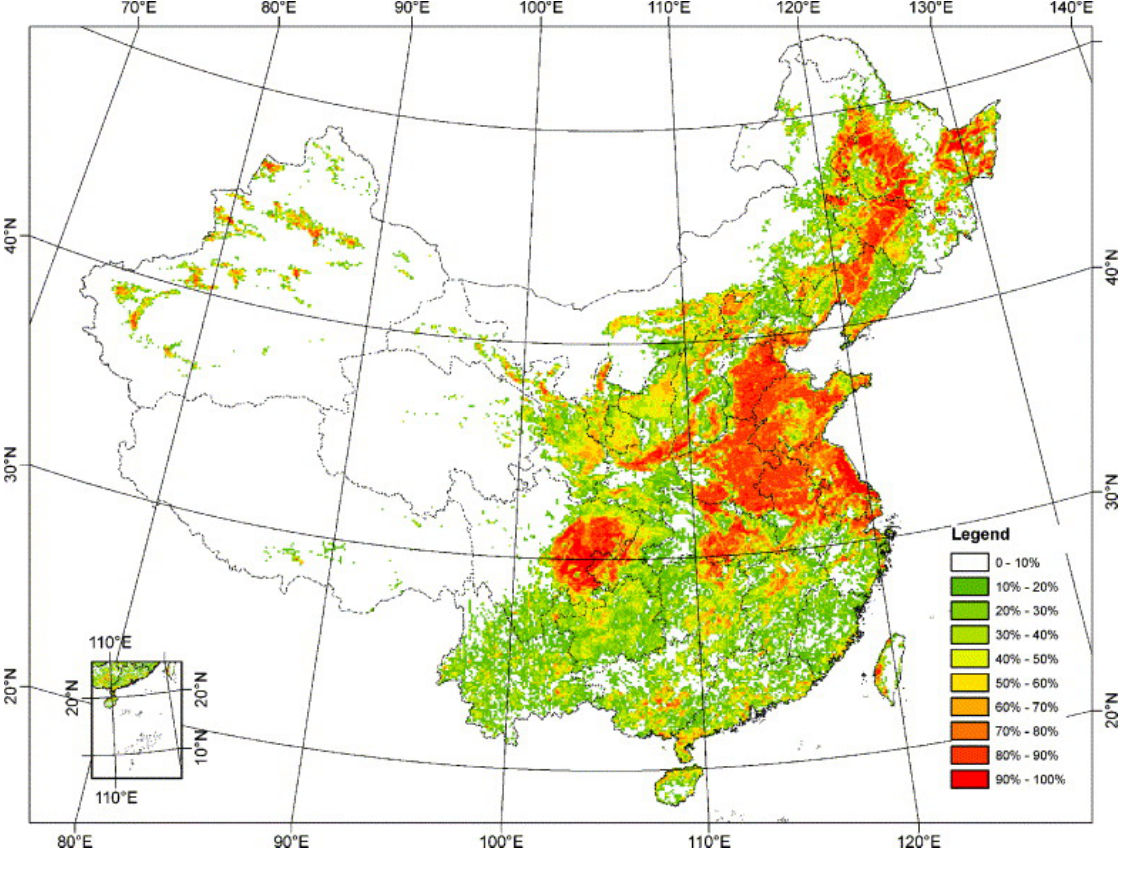
Figure 11. A cropland distribution map of China at 30 m resolution adopted from